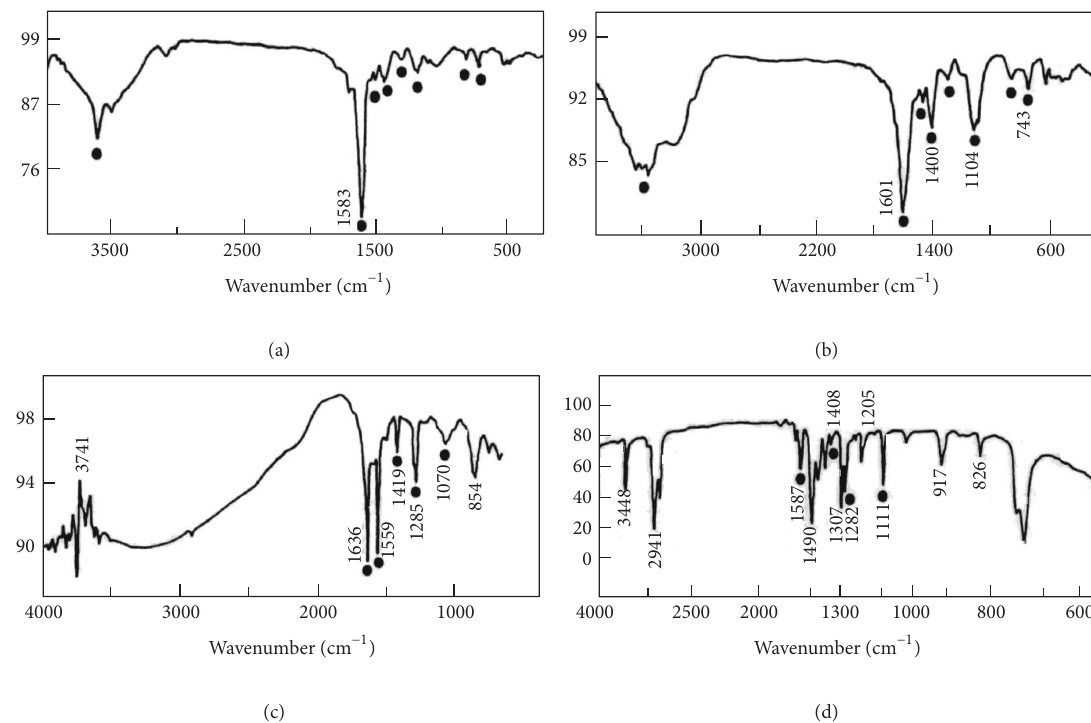
F 8: Infrared spectra of (a) extracted product from electrolyzed o -AP solution; (b) chemically synthesized 2-aminophenoxazin-3-one (3APZ); (c) POAP �lm (prepared on Pt by cyclic voltammetry, 400 cycles); and (d) model compound (phenoxazine)